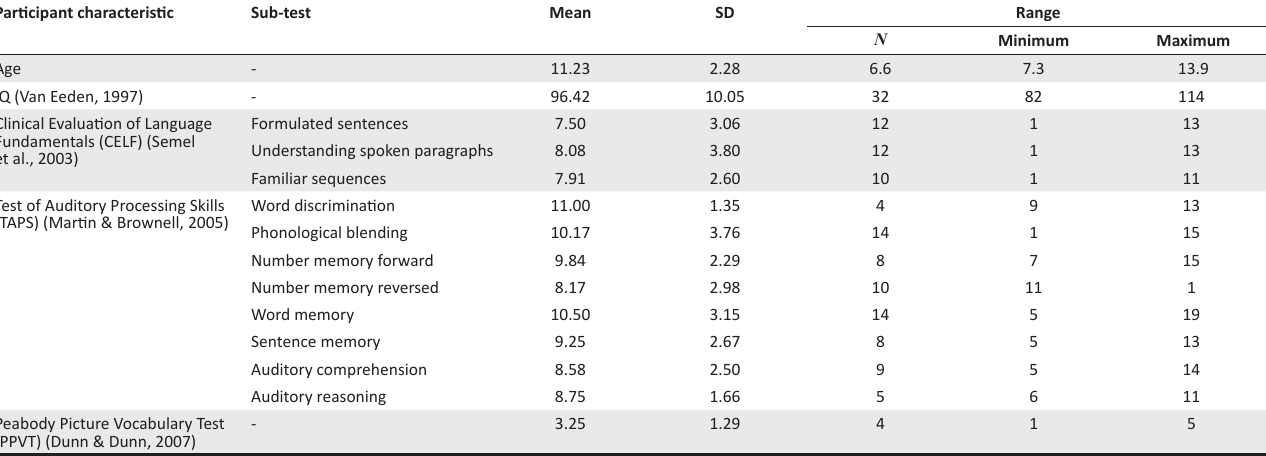
TABLE 1: Demographics of study participants. Participant